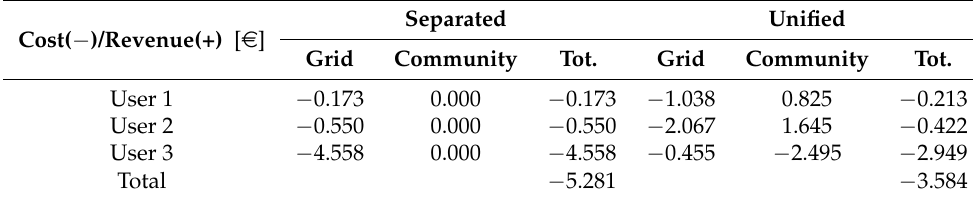
Table 5. Costs/revenues for the Separated and Unified